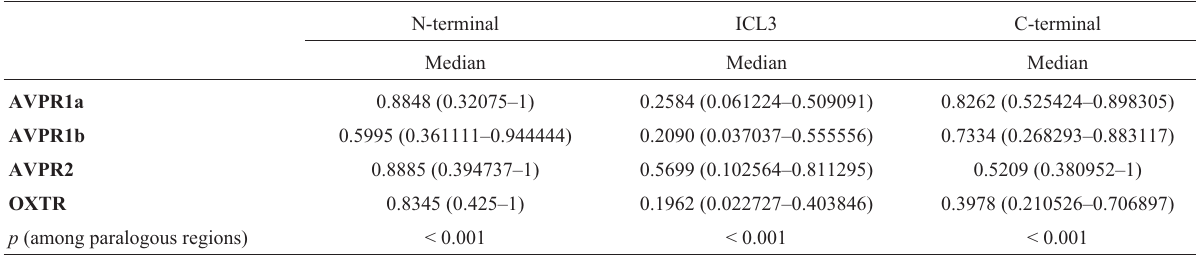
Table 2 - Median values of the proportions of residues predicted as intrinsically disordered for the N-terminal, ICL3, and C-terminal regions of OXTR, AVPR1a, AVPR1b, and AVPR2, as well as comparison among receptors for each domain considering 35 placental mammals a .